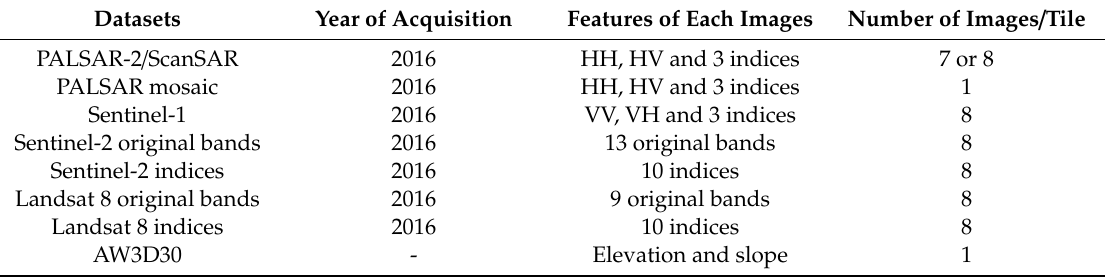
Table 2. Organization of datasets, the number of images for each 1 ◦ × 1 ◦ tile.